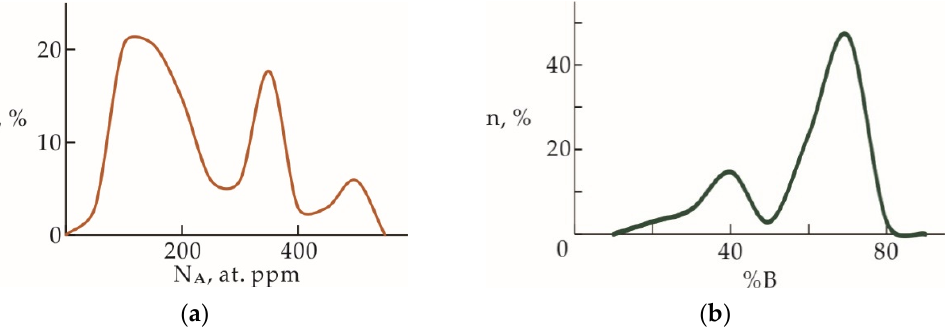
Figure 5. Nitrogen-content distribution of the Hunan diamonds: ( a ) By the contents of nitrogen A-centers; ( b ) By the extent of nitrogen aggregation(%B). n, diamond content in collections (%).